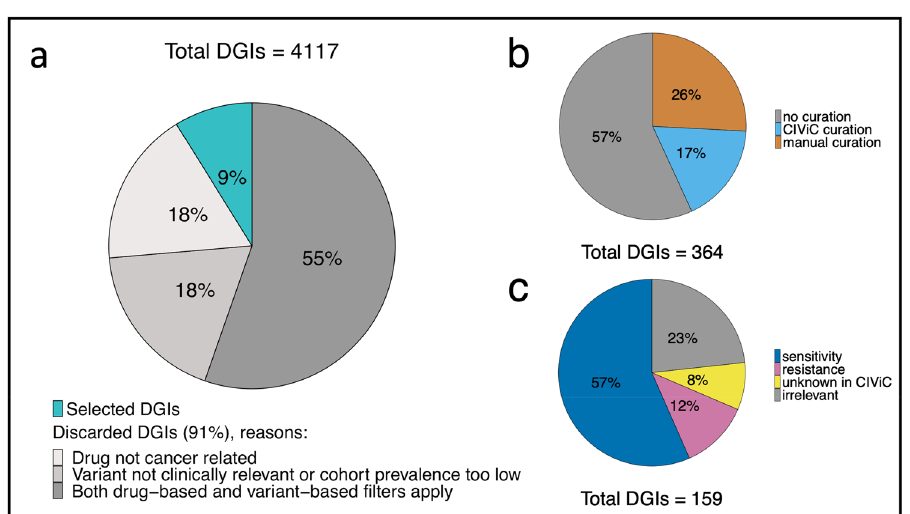
Figure 4. Influence of automated and manual filtering on the number of drug-gene interactions (DGIs). ( a ) The pie chart illustrates the fraction of DGIs filtered in an automated fashion, grouped by filter criteria. In ( b ), the fractions of DGIs that underwent curation or CIViC query are shown (note that not all available DGIs were manually curated, as this was beyond the scope of this study), whereas in ( c ), the assessment categories of the manually or CIViC curated DGIs are depicted. Note that combination treatments are excluded in this plot, since they all refer to the same DGIs and would thus be counted twice. (R Core Team (2019). R: A language and environment for statistical computing. R Foundation for Statistical Computing, Vienna, Austria. https ://www.R- proje ct.org/) 57